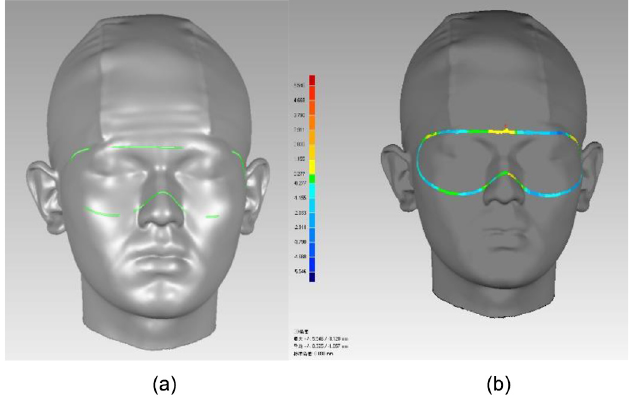
Fig. 23. Virtual wear veri fi cation.